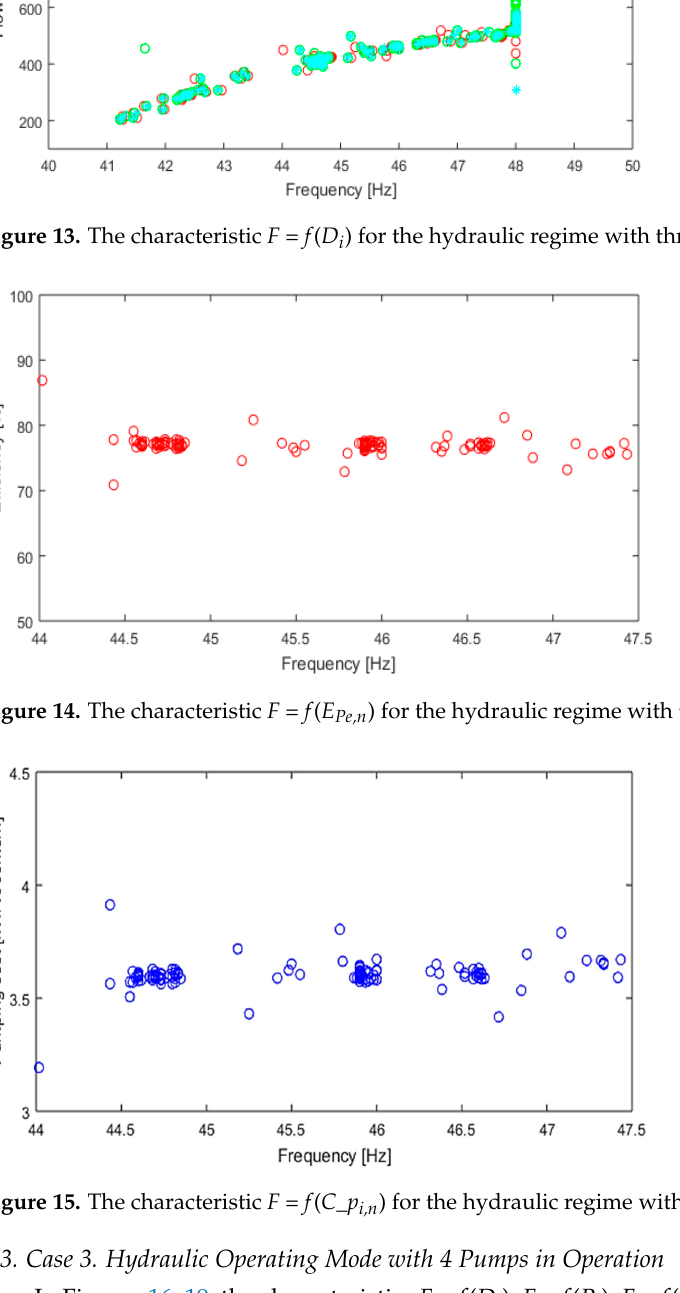
13 of 19 Figure 11. The characteristic F = f ( C_p i,n ) for the hydraulic regime with two pumps in operation. 3.2. Case 2. Hydraulic Operating Mode with 3 Pumps in Operation In Figures 12–15, the characteristics F = f ( D i ), F = f ( P i ), F = f ( E Pe,n ) and F = f ( C_p i,n ) for the case with three pumps in operation are represented. In this case, the pumps in opera- tion are P1, P2 and P4. From the F = f ( D i ) and F = f ( P i ), characteristics in Figures 12 and 13, a large frequency band of operation can be observed [41.2–47.9], in addition to some sparse values that were excluded in the maximum efficiency point determination. The best degrees of efficiency and the minimal pumping costs are registered in a frequency band [44.5–46.5], Figures 14 and 15.